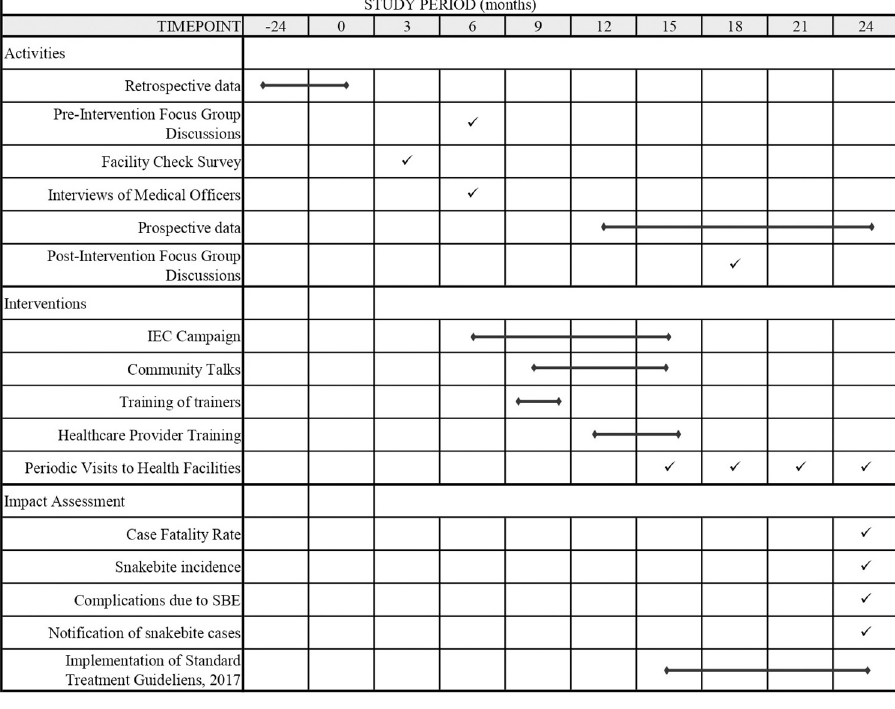
Fig 1. Timeline of the